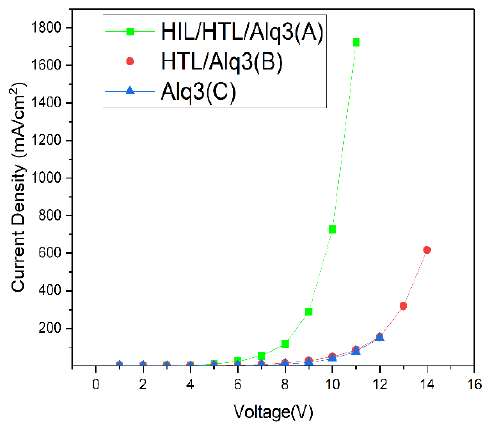
Figure 3. The curves of current density and voltage characteristics with linear – linear scale.